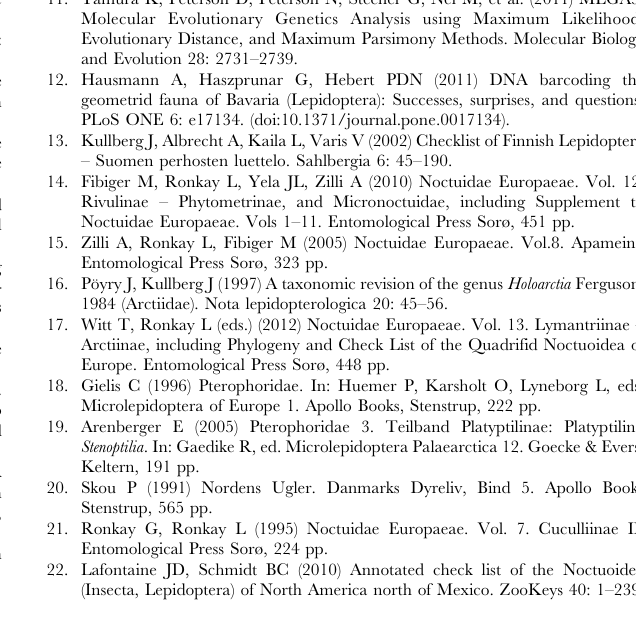
Table S1 List of specimens with sequence and collection data information.